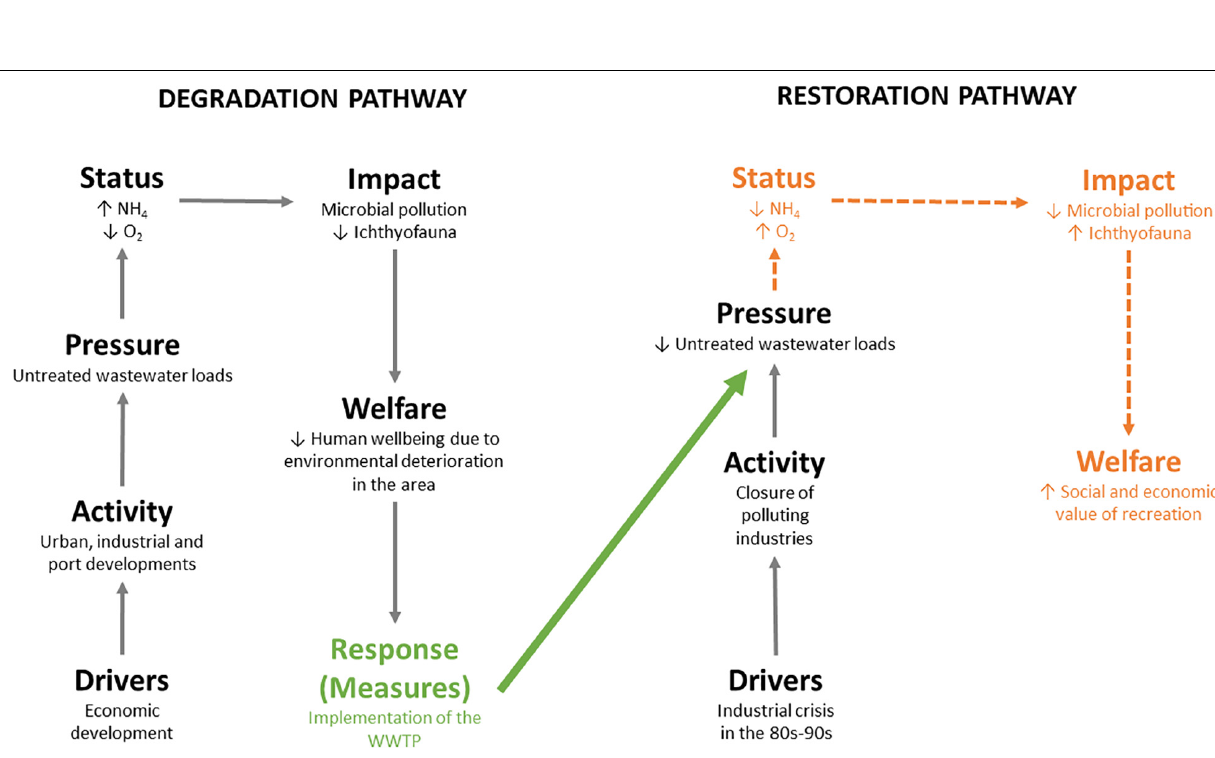
Frontiers in Marine Science |